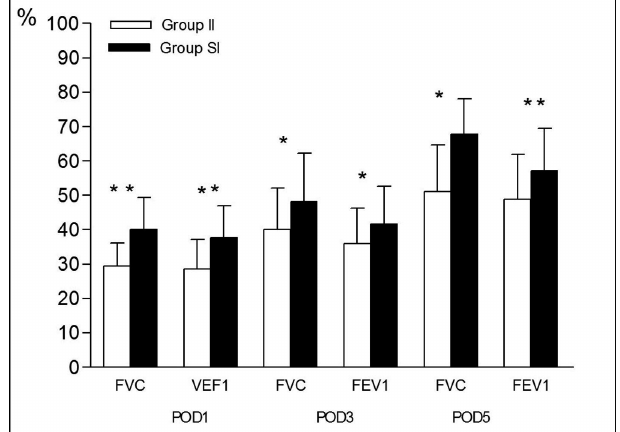
Fig. 2 - Pulmonary function test values on the POD1, 3 and 5, in percentage considering 100% preoperative baseline value. Data are shown as mean ± standard deviation. BMI=body mass index; FEV1=Forced expiratory volume in 1 second; FVC=forced vital capacity; II=intercostal insertion; SI=subxyphoid